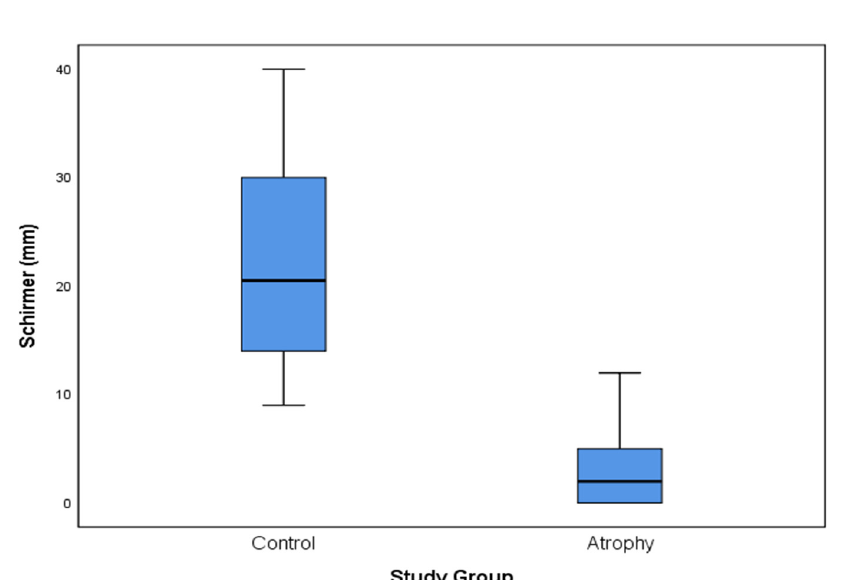
Table 4. Correlations between the different measures . Pearson’s correlation coefficient is a measure of the linear correlation between these parameters. Correlation coefficients of 1 or − 1 represent per- fect correlations, whereas a correlation coefficient of 0 represents no correlation. Thus, the closer to 1 or − 1 the value of the coefficient is, the stronger the correlation. Modified Schirmer (mm)